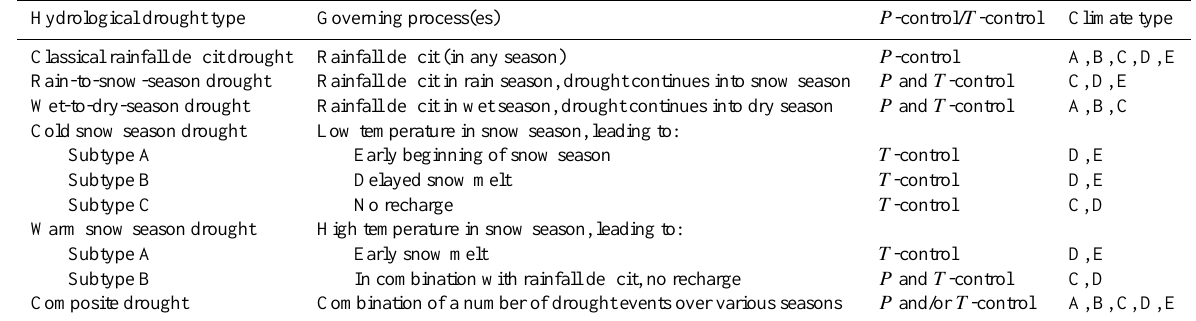
Table 6. Drought propagation processes per hydrological drought type and occurrence in K¨oppen-Geiger major climate types. Hydrological drought